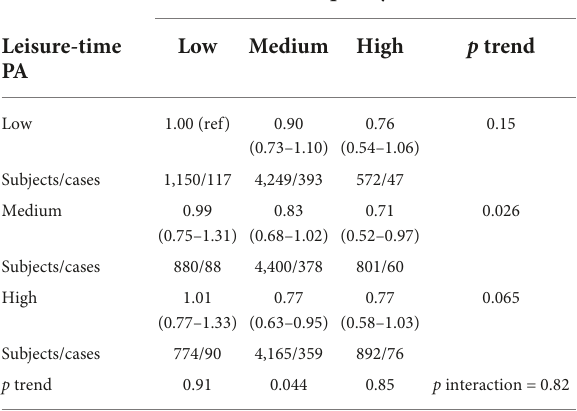
TABLE 3 Joint analyses of overall diet quality and leisure-time PA in relation to aIS in the MDCS ( n = 19,491). Diet